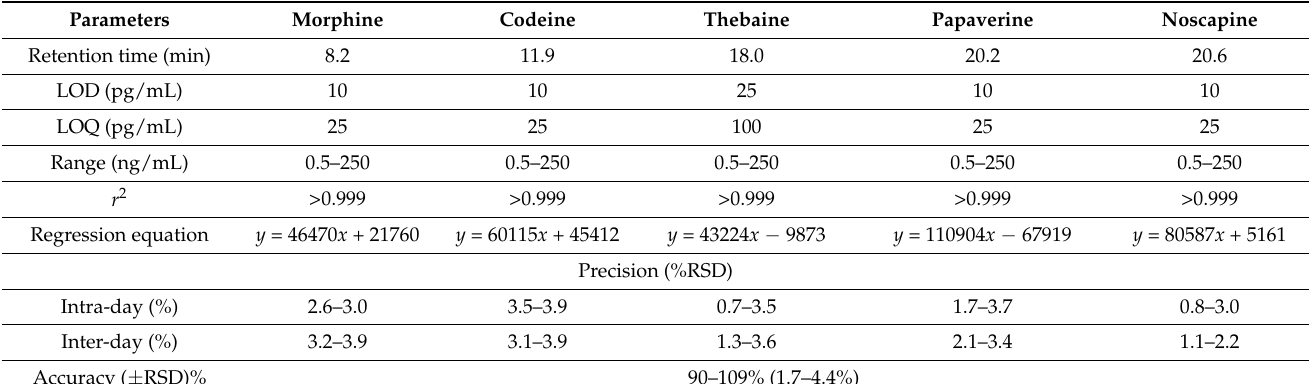
Table 2. LC-QToF-MS validation parameters for poppy seeds